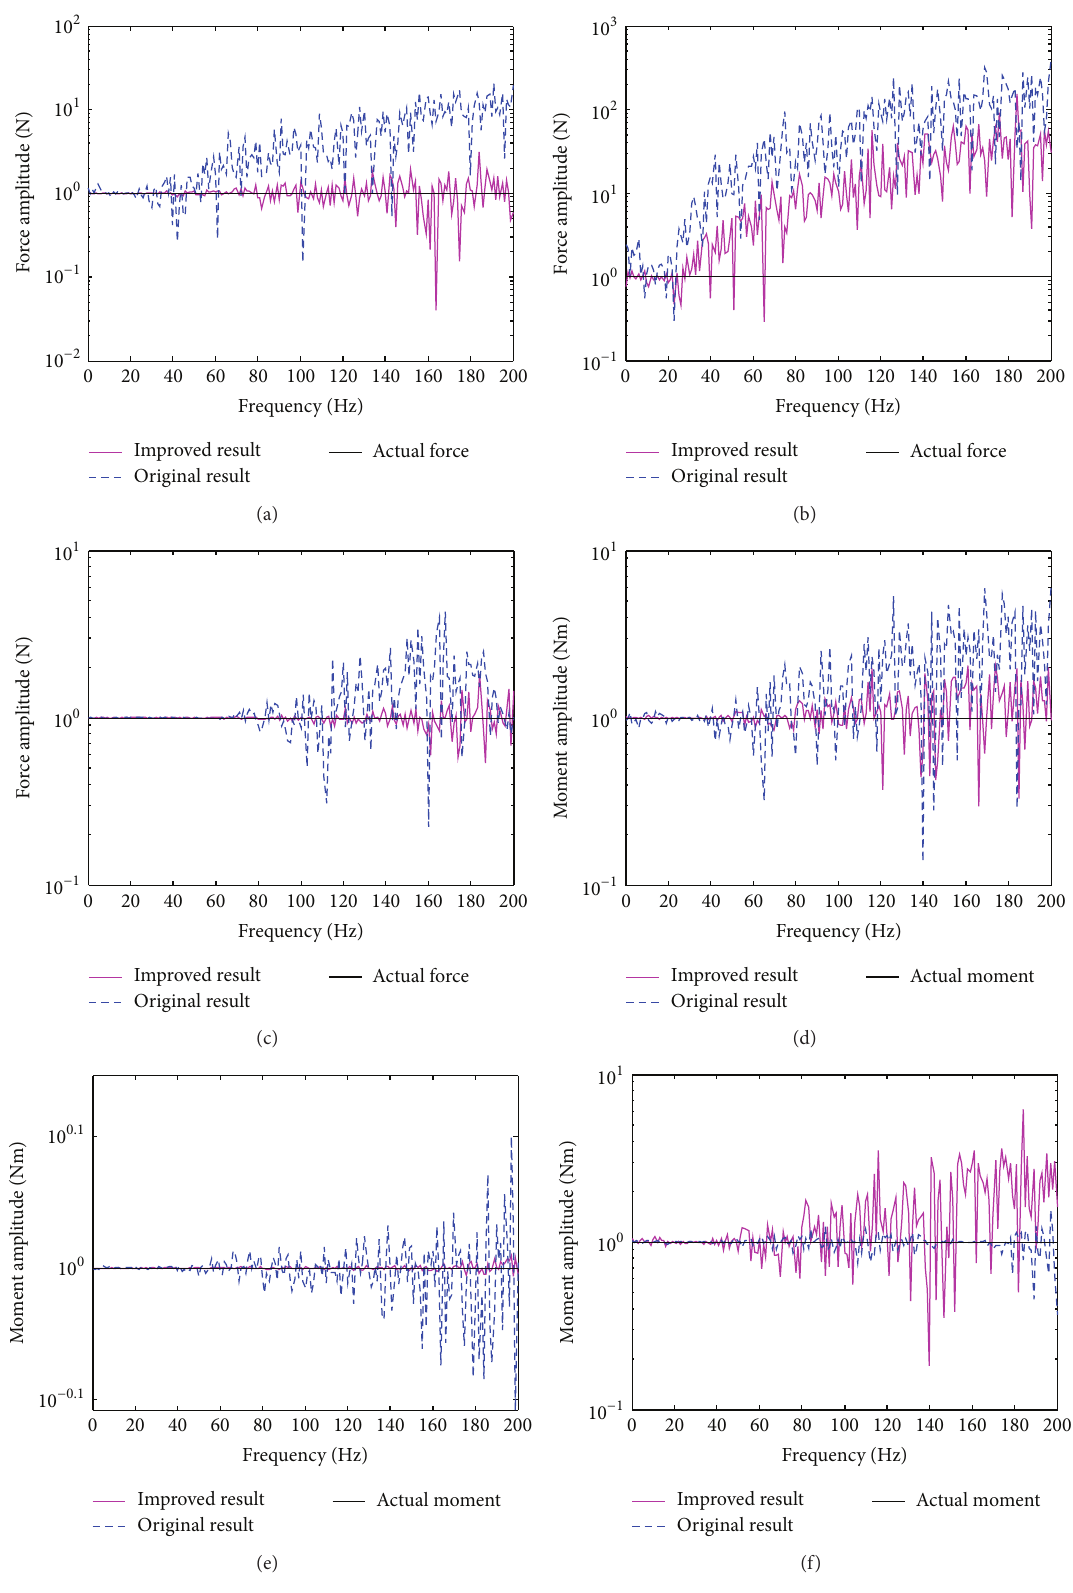
Figure 6: Comparison of improved results and original results. (a) Force in 𝑥 -direction. (b) Force in 𝑦 -direction. (c) Force in 𝑧 -direction. (d) Moment around 𝑥 -direction. (e) Moment around 𝑦 -direction. (f) Moment around 𝑧